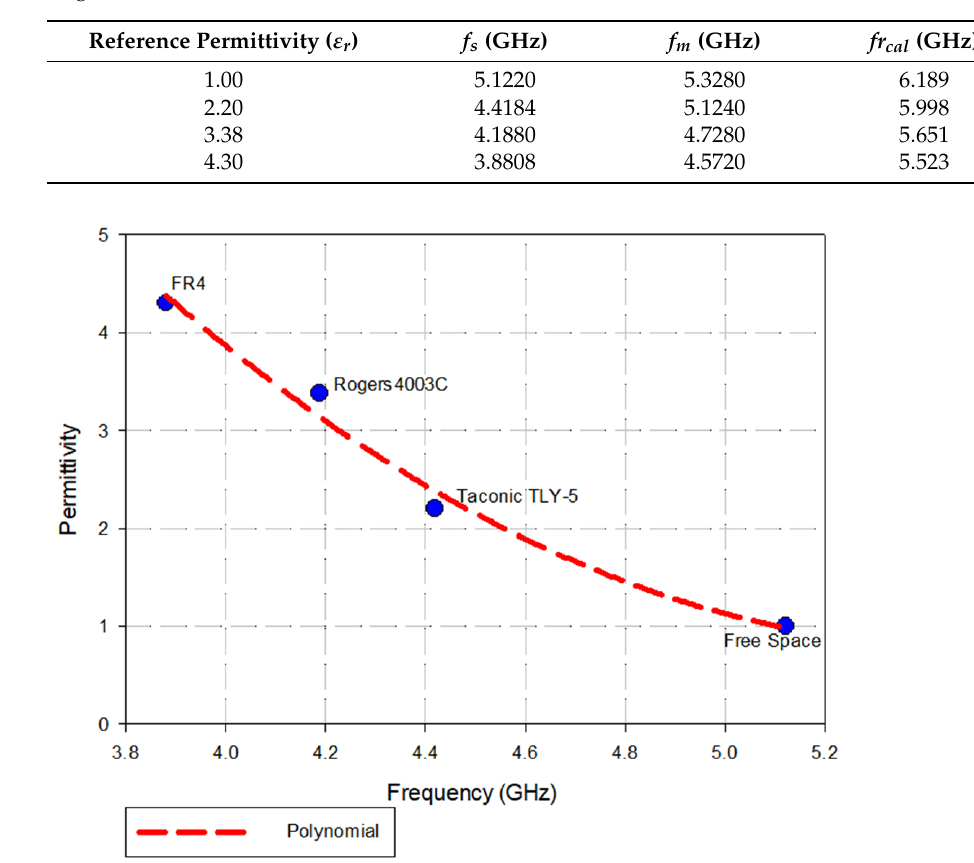
Table 5. Measured frequency, simulated frequency, and calibrated frequency of the proposed square ring resonator.